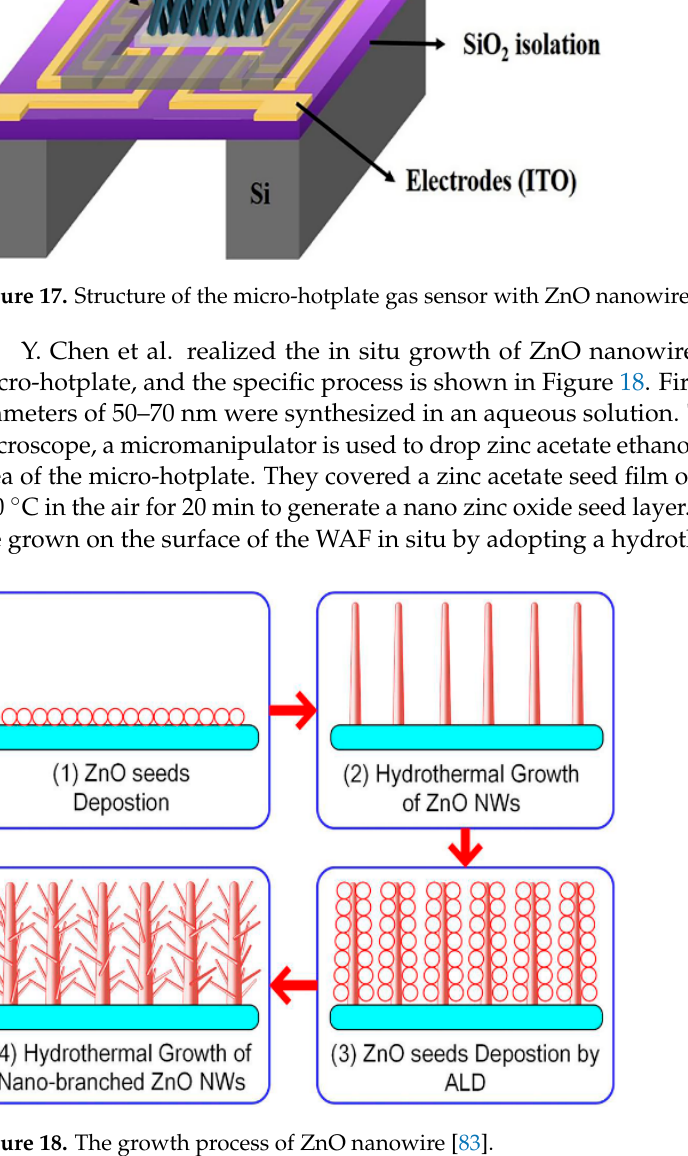
Figure 16. Diagram of the preparation process of in-situ growth of ZnO on FTO gas-sensing elec- trode [80].